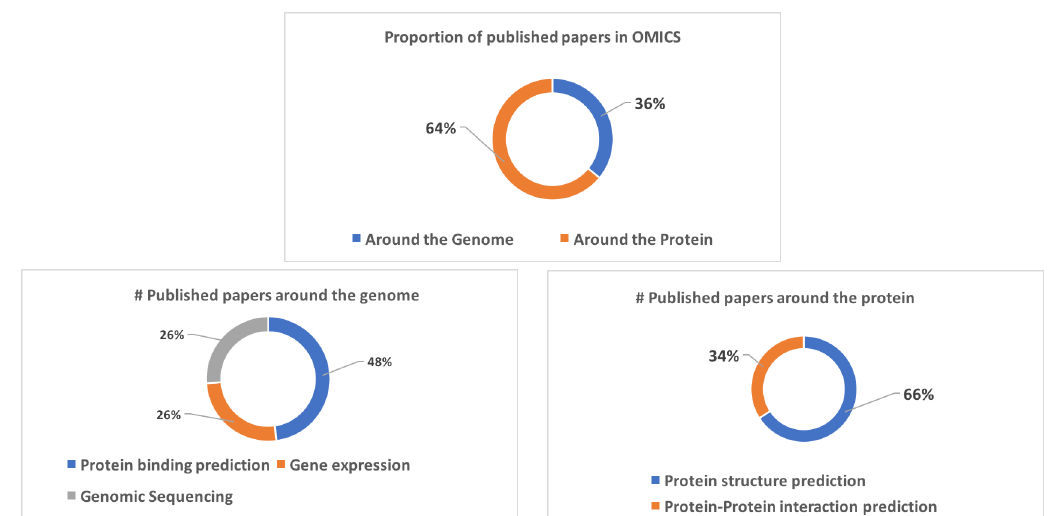
Figure 12. Distribution of the Omics papers reviewed in this survey.